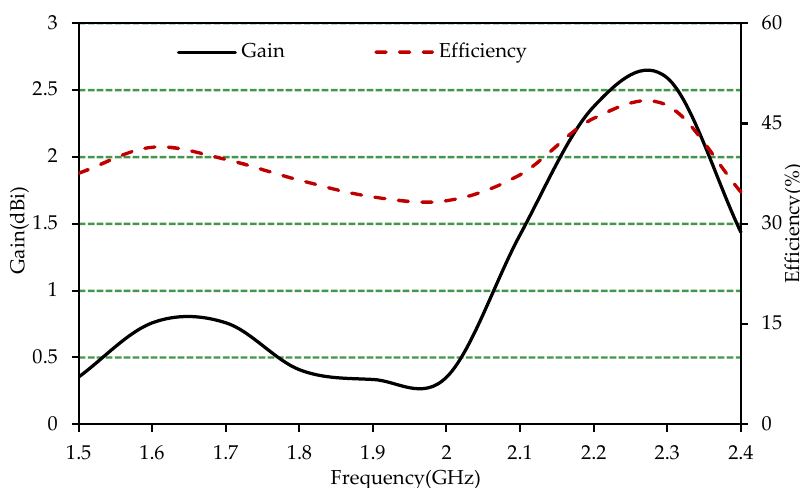
Figure 5. Measured gain and efficiency of the proposed antenna.